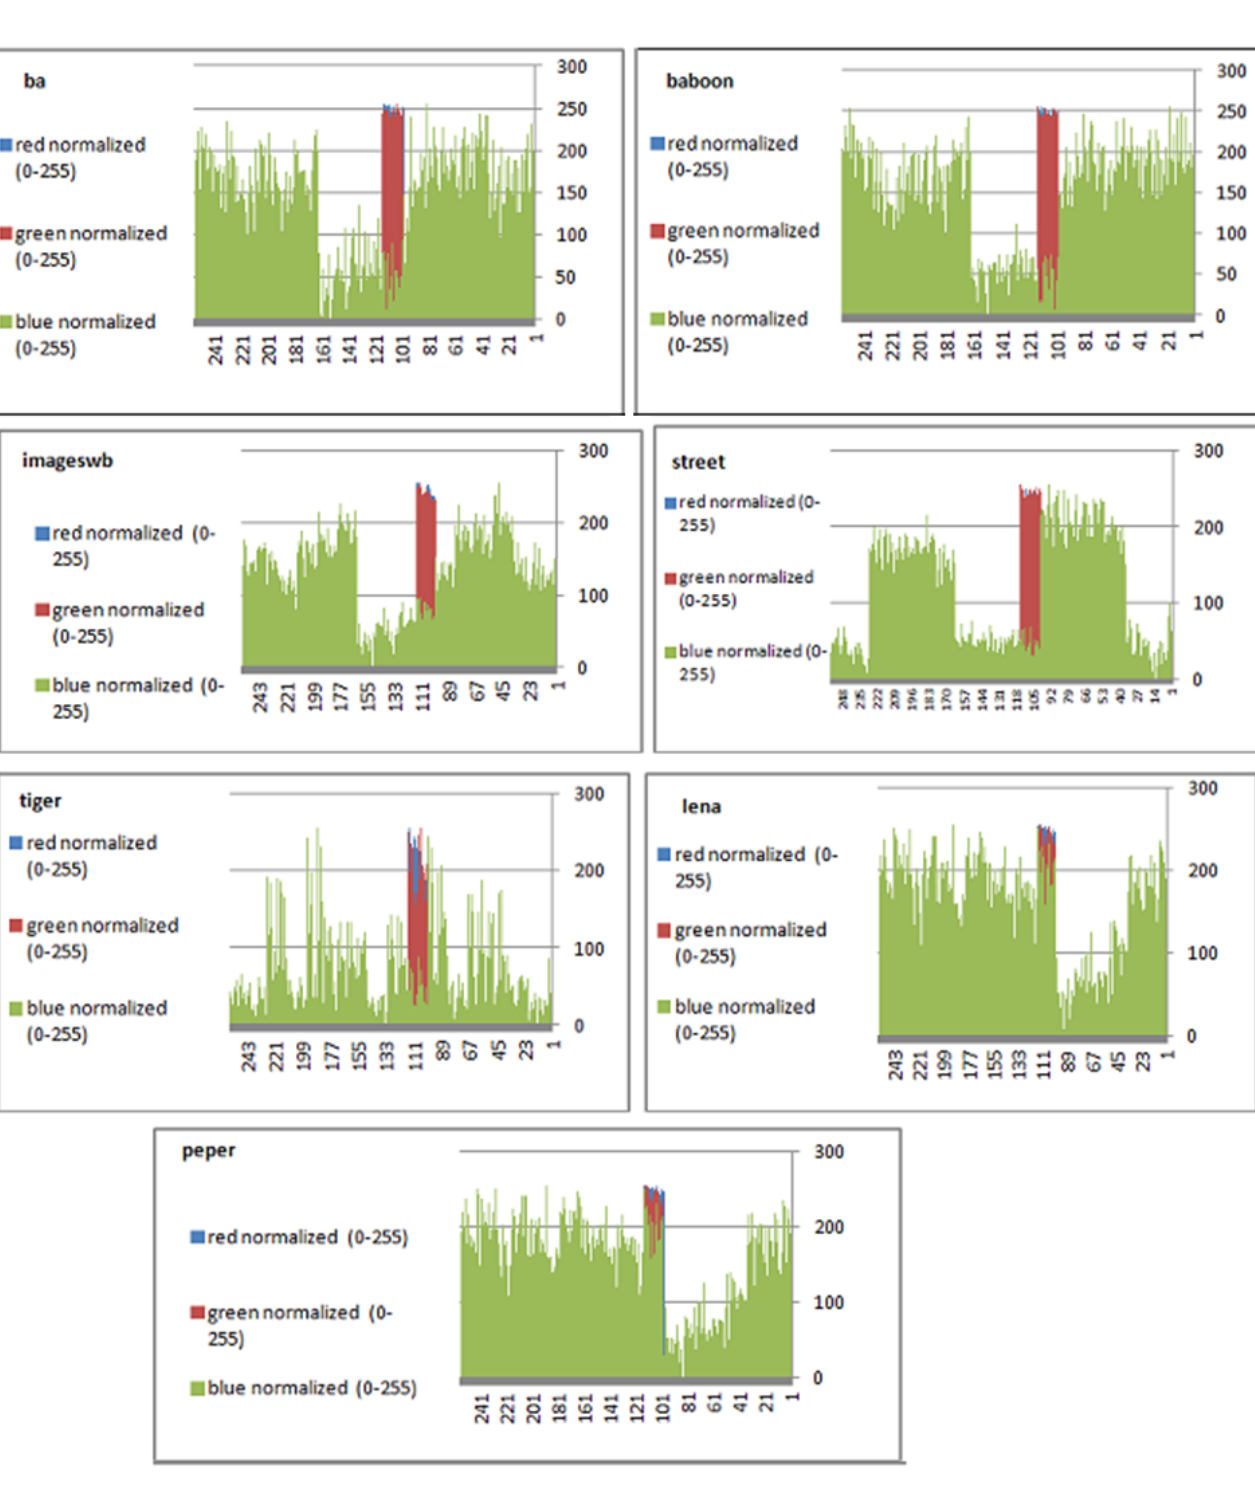
Figure 4. Histogram of the plain